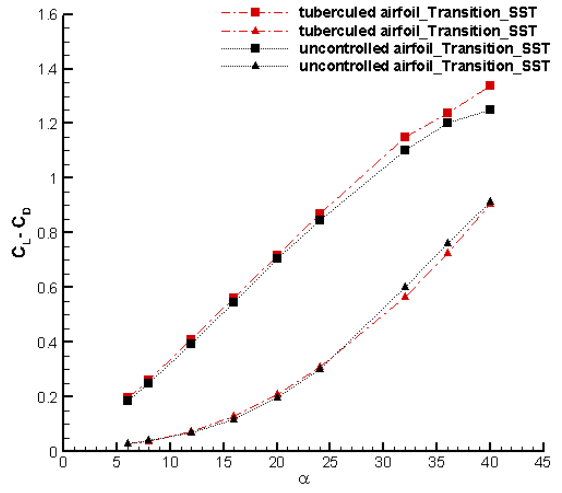
Fig. 3. Aerodynamic for coefficients for the Transition SST turbulence model.